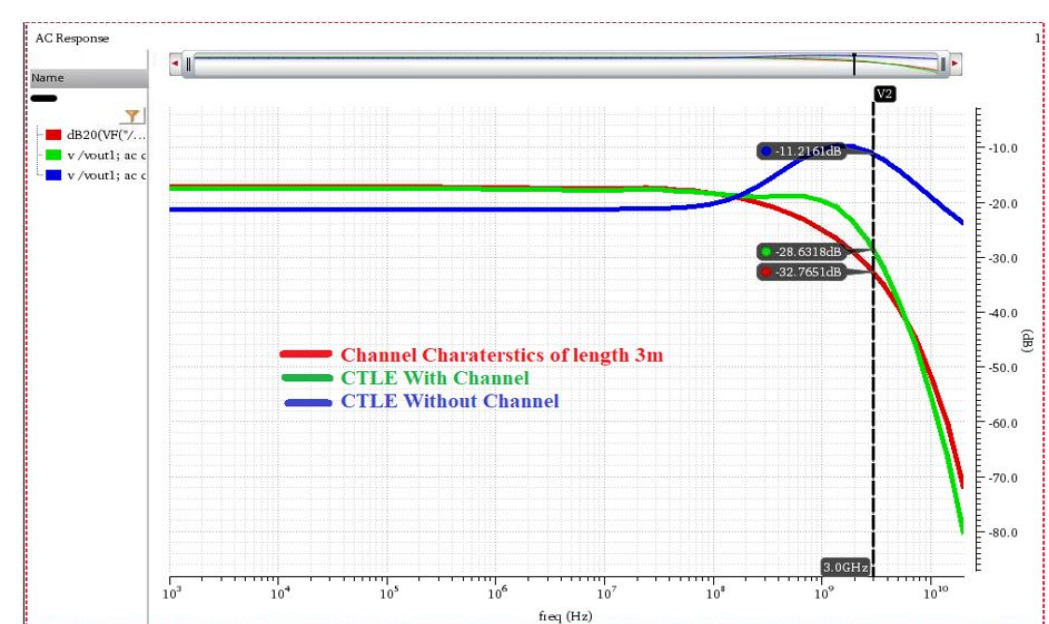
Figure 11. Simulated Frequency Response for the CTLE.